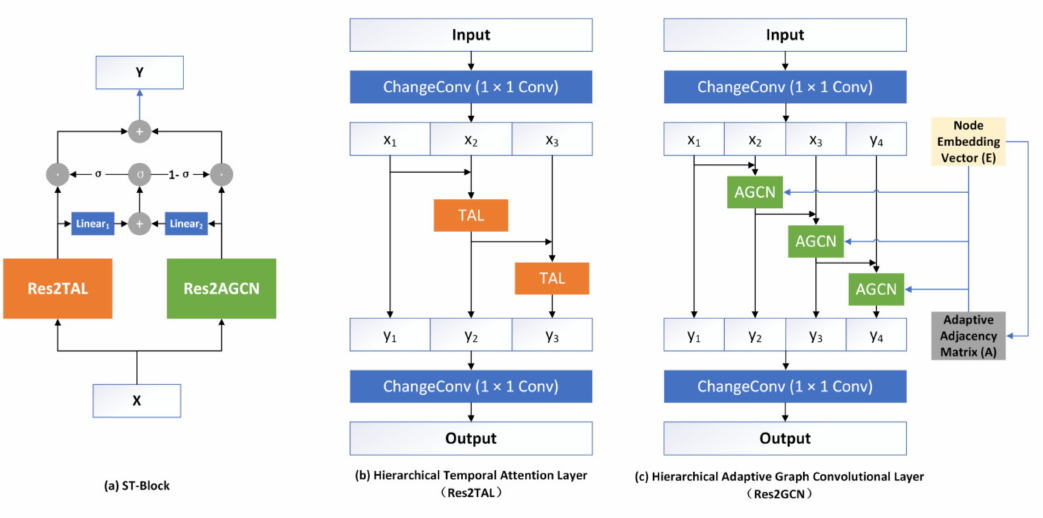
Figure 2. The ( a ) ST Block of TRes2GCN. The framework of ( b ) hierarchical temporal attention layer and ( c ) hierarchical adaptive graph convolution